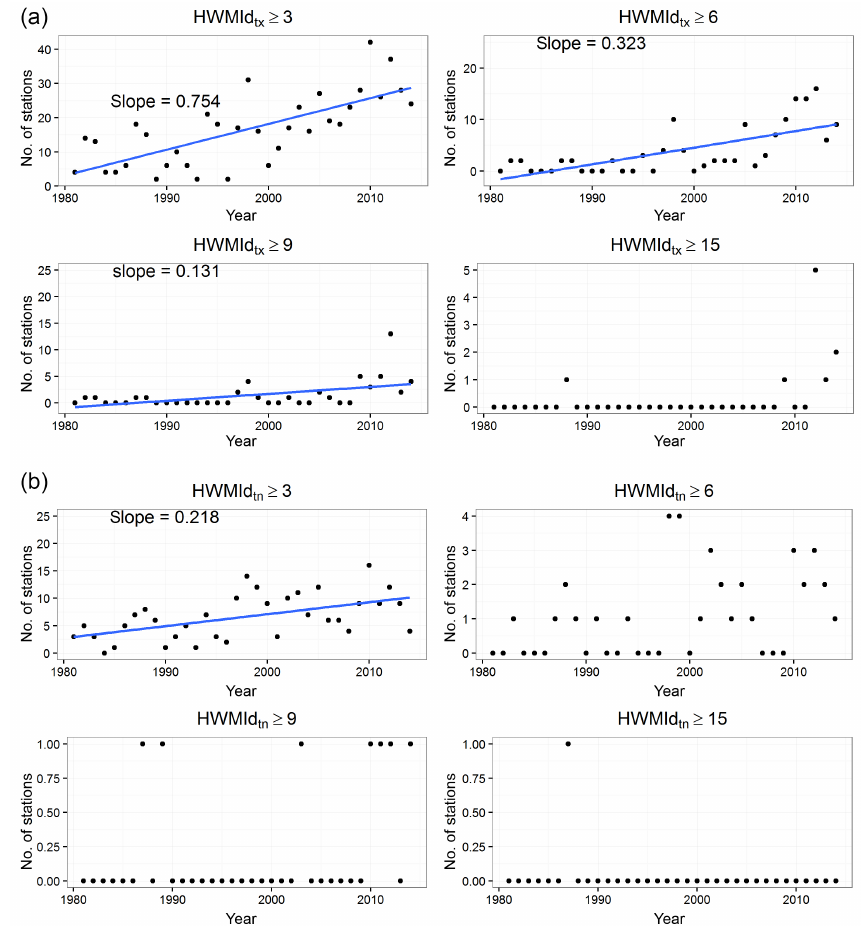
Figure 3. Annual distribution of events exceeding four different thresholds (i.e. HWMId ≥ 3, 6, 9, 15) for maximum (top panel) and minimum (bottom panel) temperature. The blue line represents the statistically significant ( α = 0.01) linear